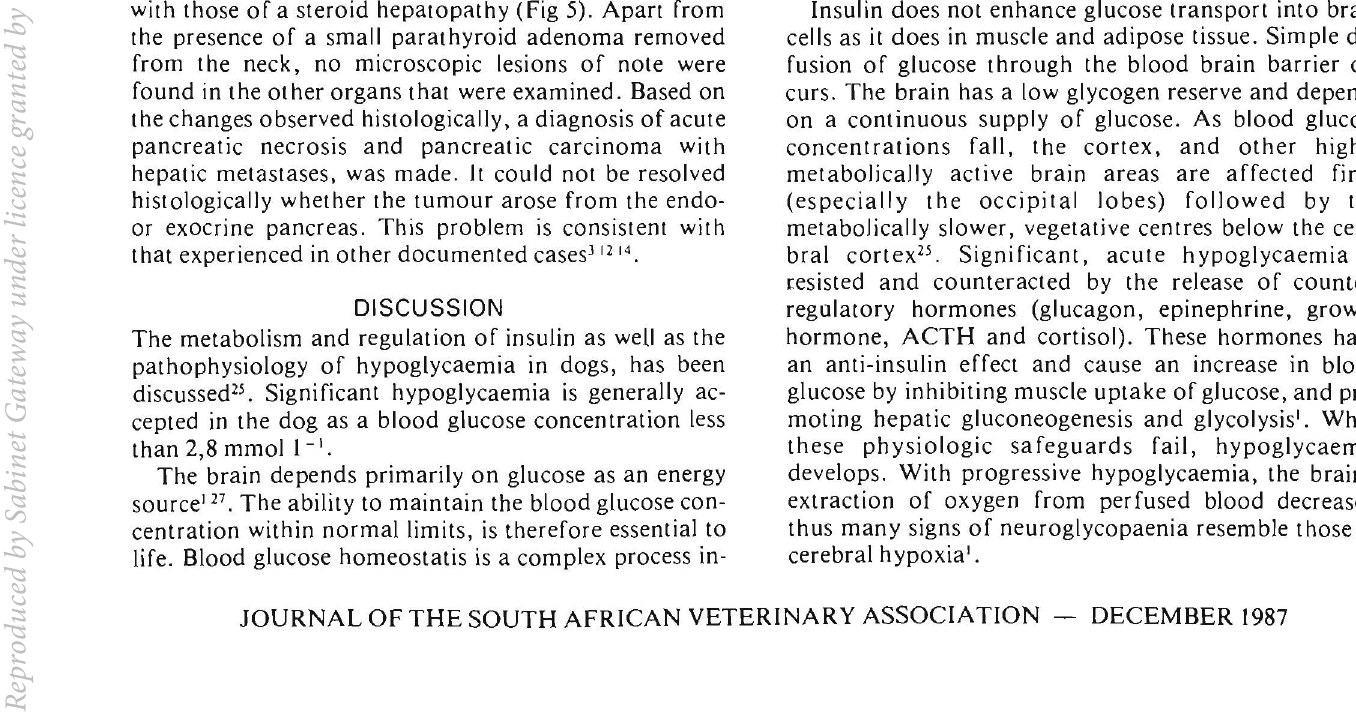
Fig. 5: Haematoxylin and eosin stained section of the liver, showing the metastatic tumour cells (x 200) volving carbohydrate intake and absorption, hepatic production and peripheral utilization